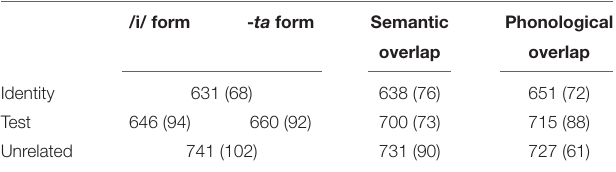
TABLE 1 | Mean lexical decision times (and standard deviations) by condition and prime type. /i/